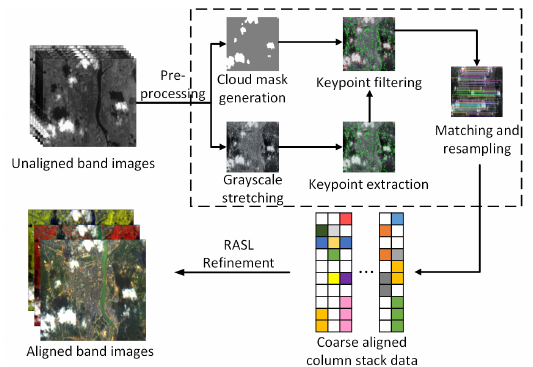
Figure 2. Flowchart of the proposed coarse-to-fine registration framework for multi/hyperspectral